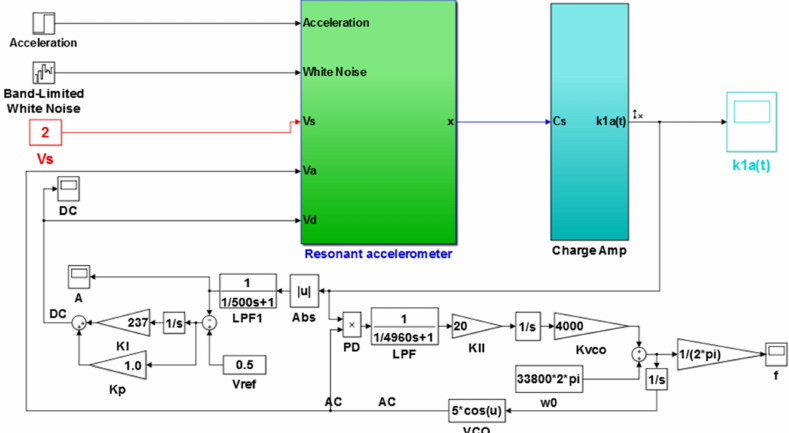
Figure 10. Simulation model of double closed-loop control for a resonant accelerometer.